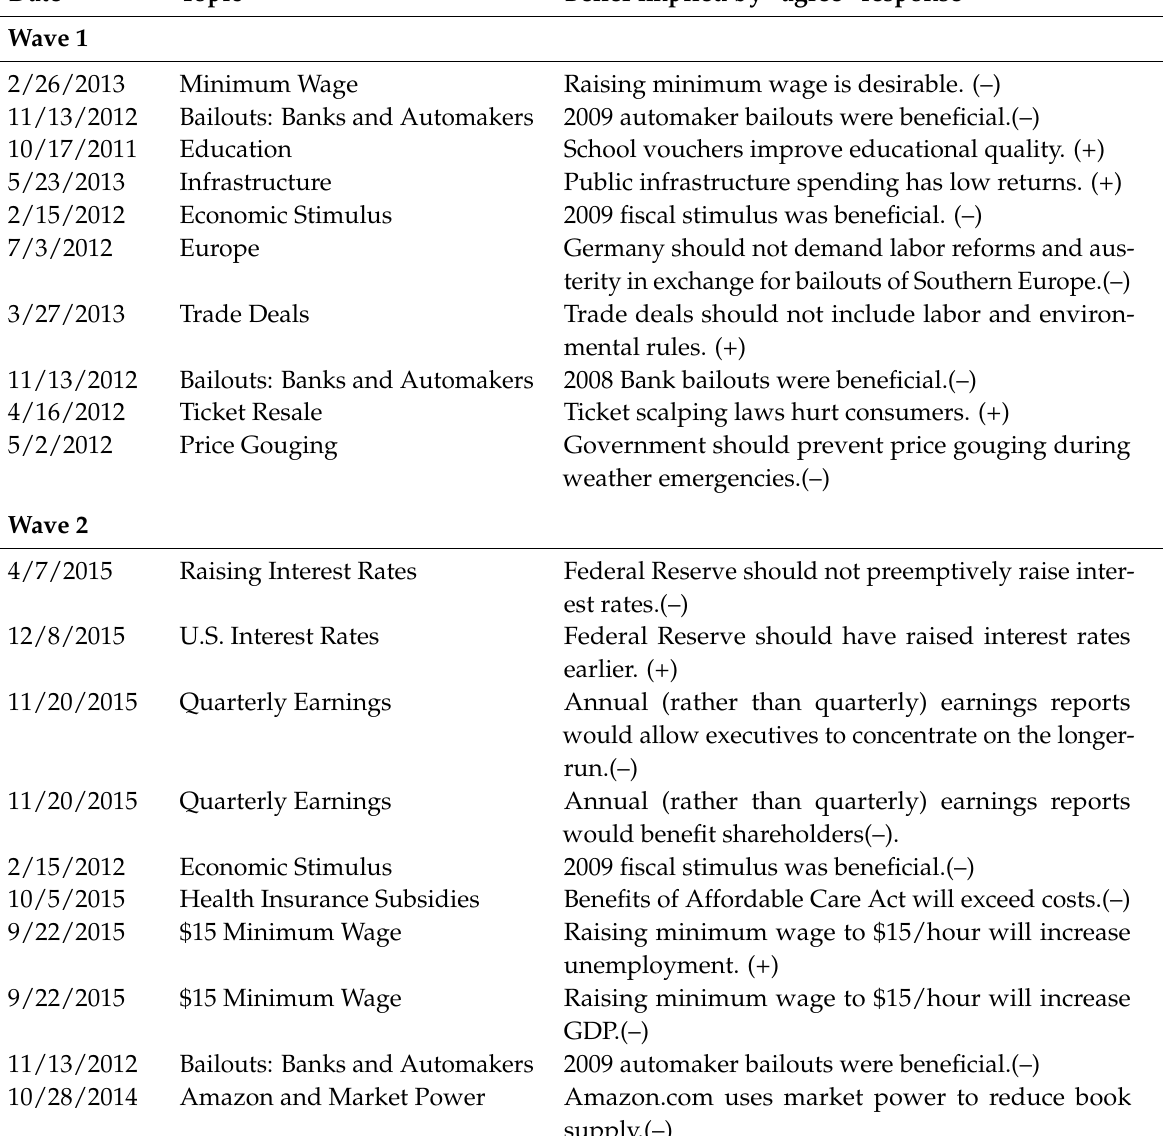
the table. Questions on automaker bailouts and economic stimulus appear in both survey waves because respondents joining the panel in the second wave were asked these questions